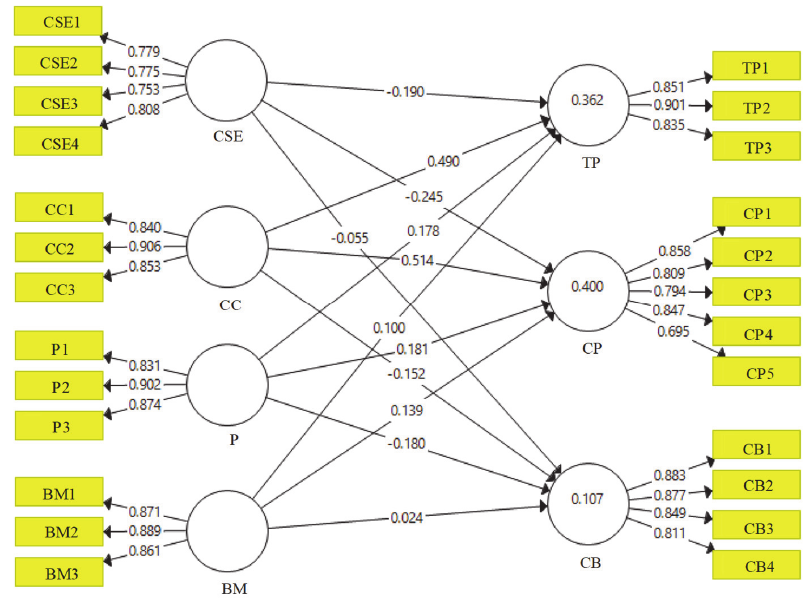
Fig. 3. Results for the hypothesized model with structural equations